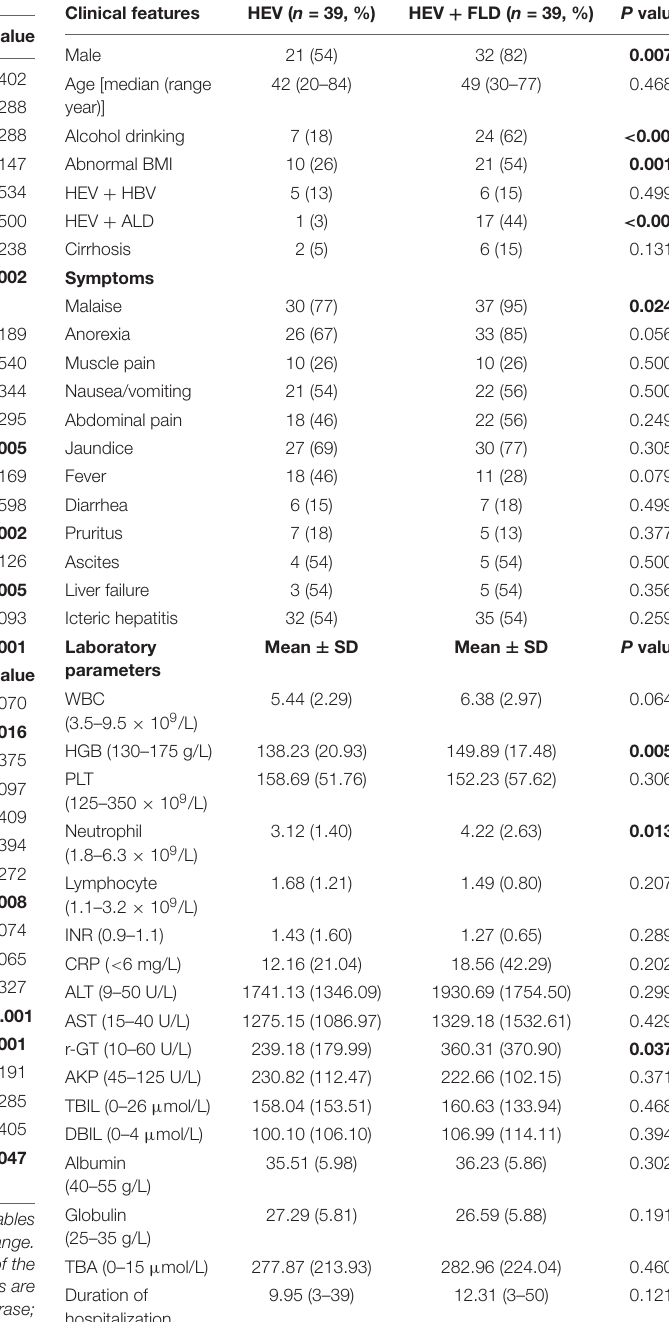
TABLE 2 | Patients demographics, clinical characteristics, and laboratory findings between the elderly group ( ≥ 60-year-old) and the non-elderly group ( < 60-year-old).